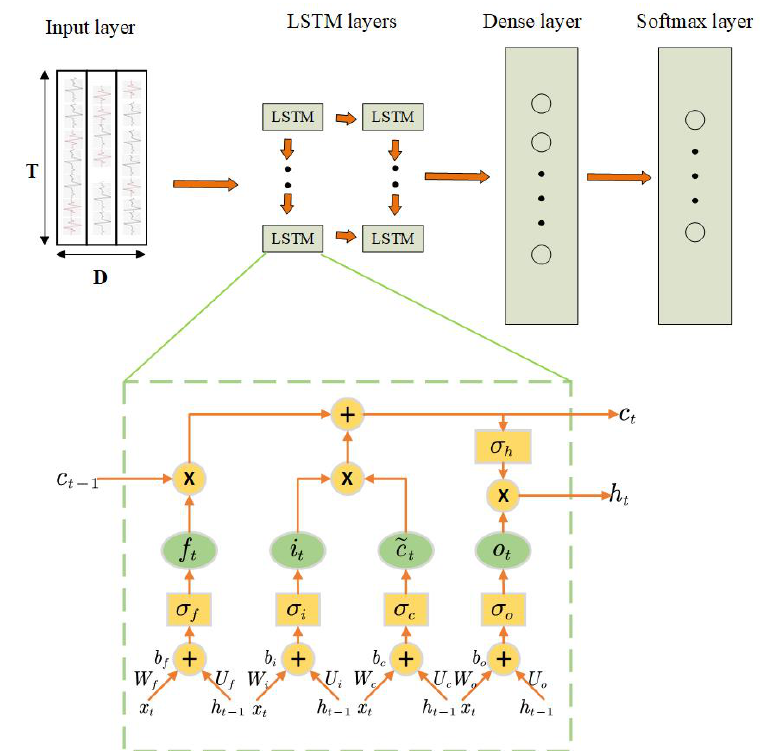
Figure 4. Architecture of a long-short term memory (LSTM) network for HAR. T in the input layer denotes the length of the time window. D denotes the number of sensor channels. Each LSTM layer is composed of an LSTM cell. ⊗ denotes the element-wise multiplication. ⊕ denotes the element-wise addition. The output of the last LSTM layer is passed to a dense and a softmax layer.